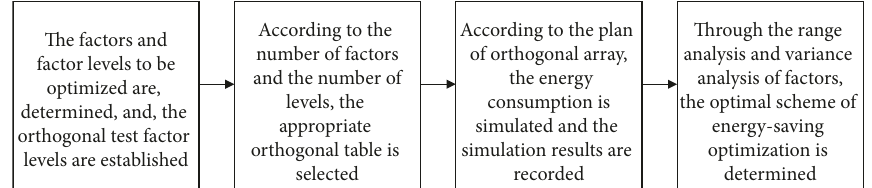
Figure 3: Optimization process of the energy-saving scheme of the envelope